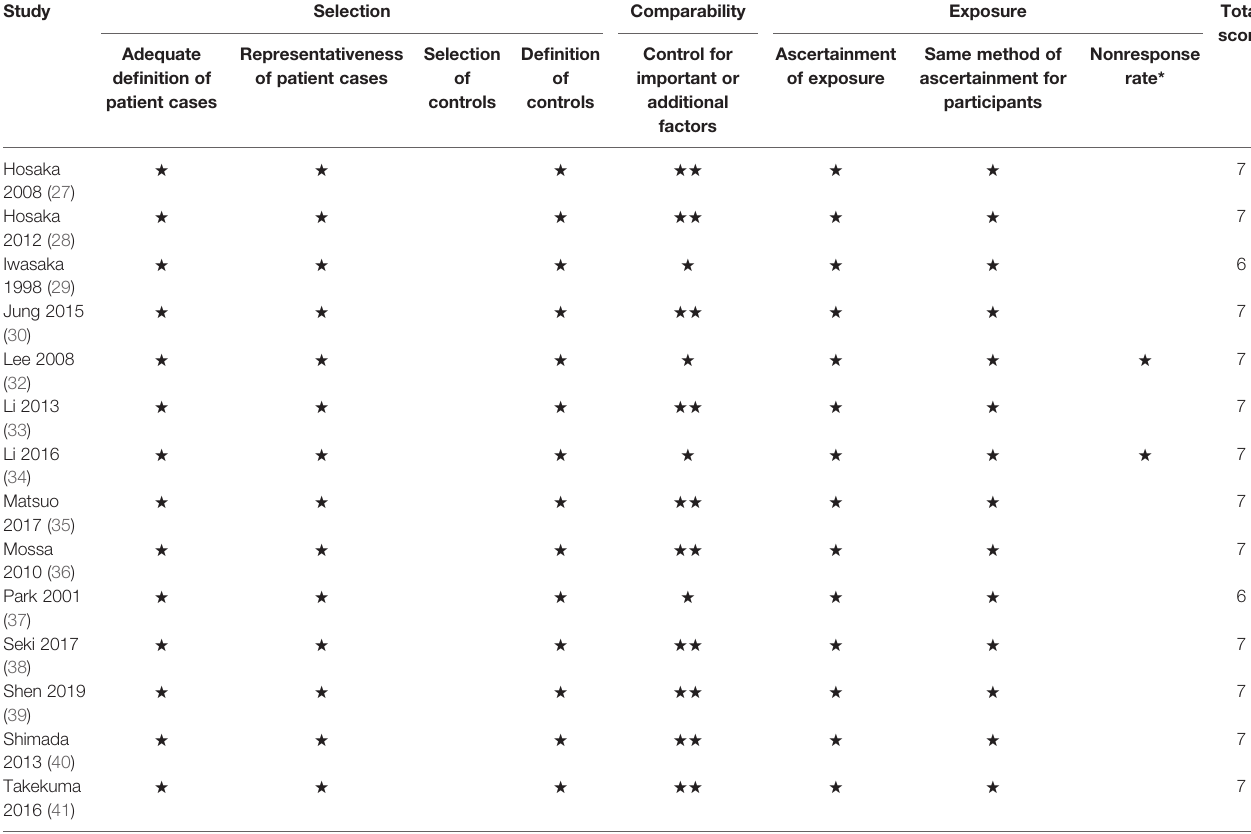
TABLE 2 | Newcastle-Ottawa scale for assessing risk of bias and quality of non-randomized